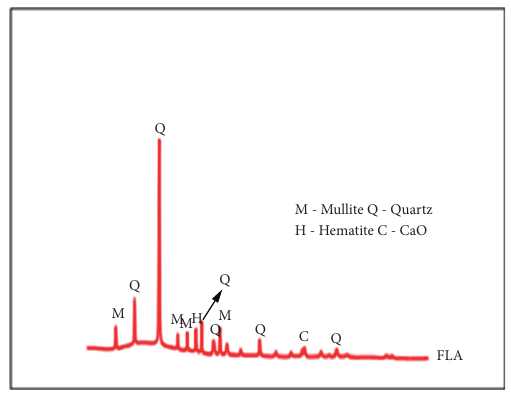
Figure 1: XRD pattern of fly ash.